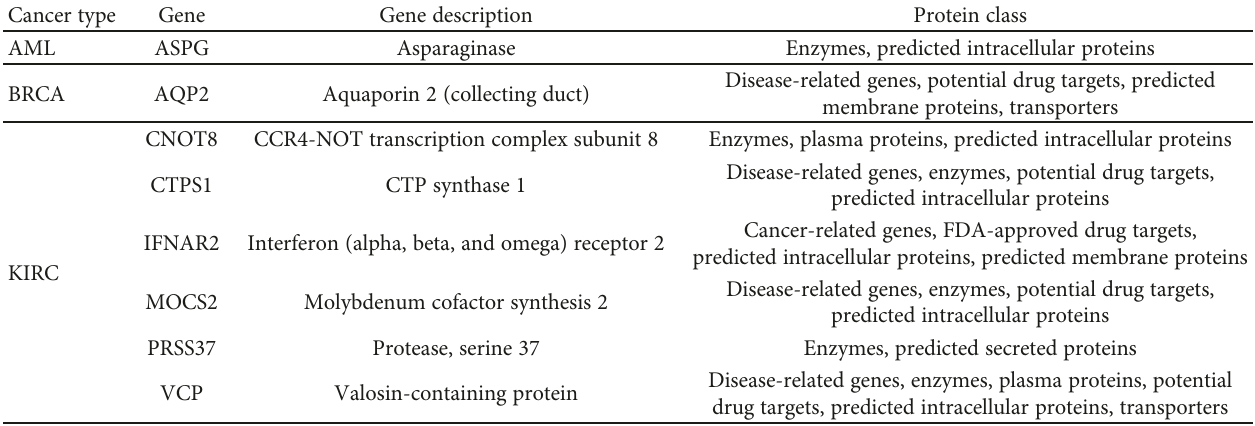
Table 6: The annotation of the key genes connected with more than three cancer-speci fi c miRNAs in the miRNA-mRNA interaction